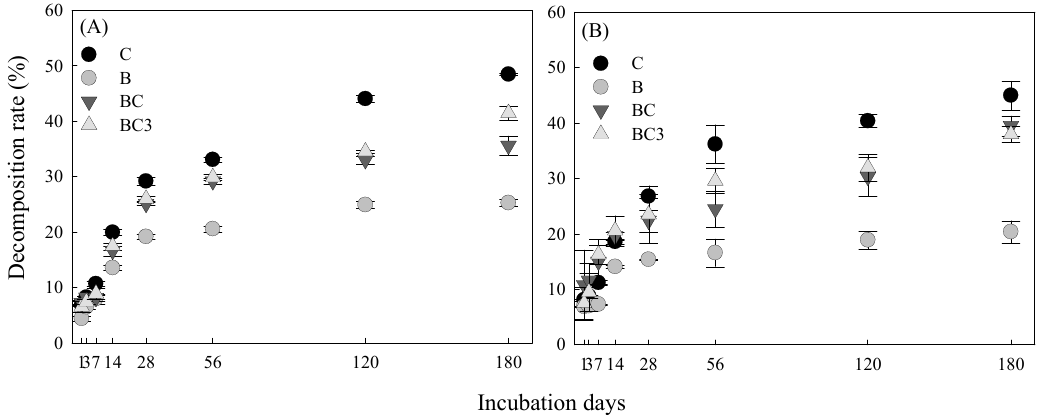
Figure 1. Dynamic changes in the material decomposition rate ( A ) sandy soil ( B ) clay